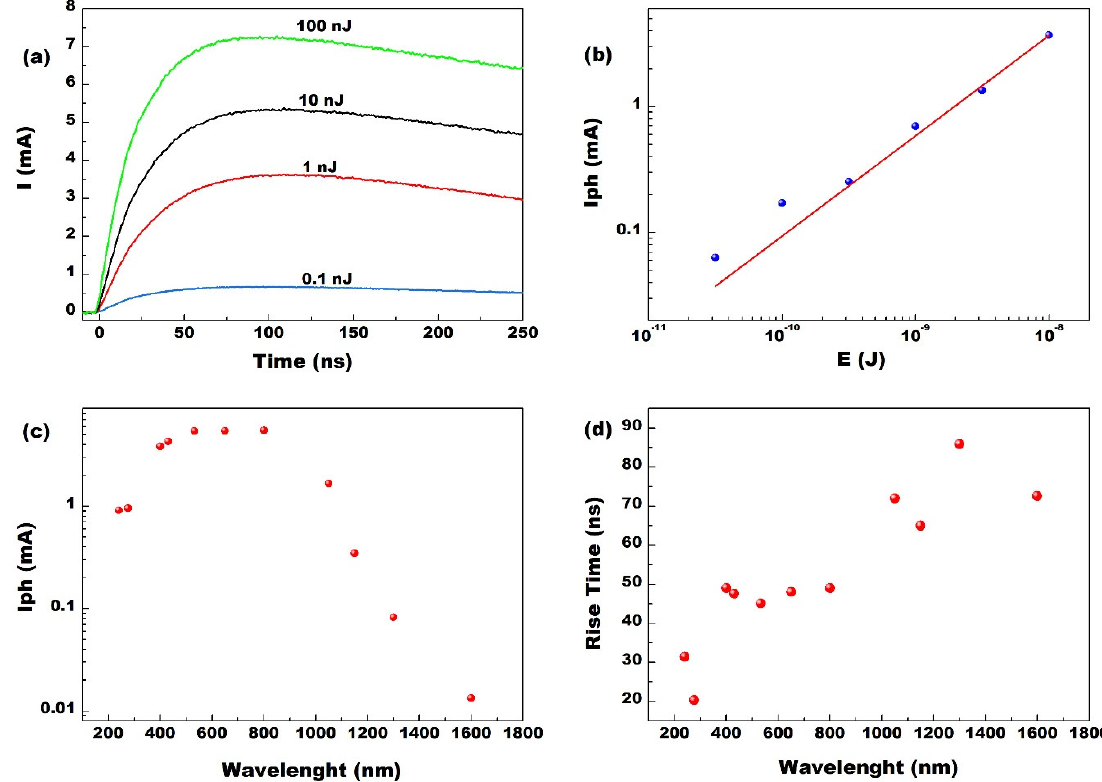
Figure 3. ( a ) Photocurrent response of the PD to a 35-fs pulsed laser at different beam energy, tuned to photon wavelength, λ = 800 nm. ( b ) Photocurrent difference, I ph , between maximum and minimum in PD response peaks vs the laser light pulse energy for λ = 800 nm; in red, the curve obtained by fitting the experimental data with a power function is shown, high- lighting a linear behavior; ( c ) I ph as a function of photon wavelength measured with an incident fs laser light pulse energy, E = 100 nJ and ( d ) rise time acquired as a function of photon wavelength of an incident 35 fs laser pulse at energy E = 100 nJ.